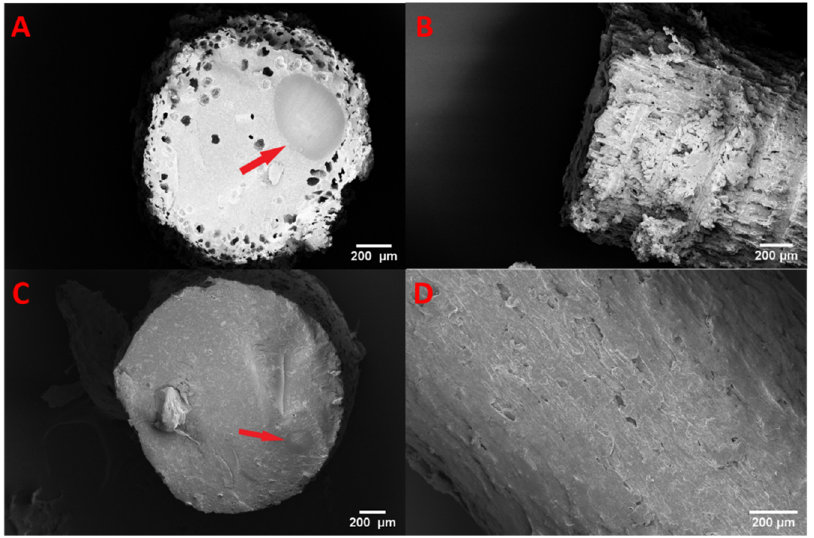
Figure 8. SEM images of mesoporous material containing filaments: ( A ) cross-section and ( B ) side view of MMC-containing filament; ( C ) cross-section and ( D ) side view of MCM-41-containing filament. The arrows indicate polymer inclusions.